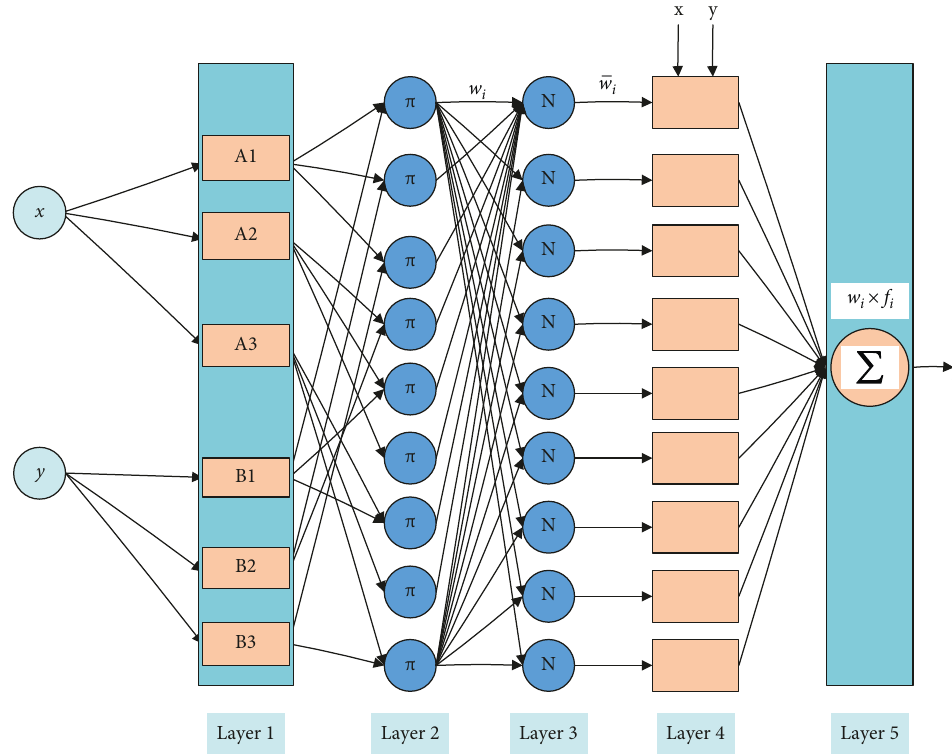
Figure 2: ANFIS architecture of two inputs and one output with four